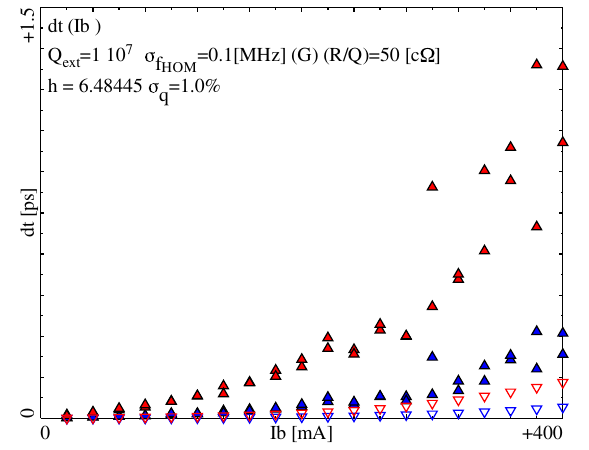
FIG. 35. (Color) Phase space at ejection for 250 independent HOMs (one per cavity) as Fig. 34 but Q ext ¼ 10 7 .